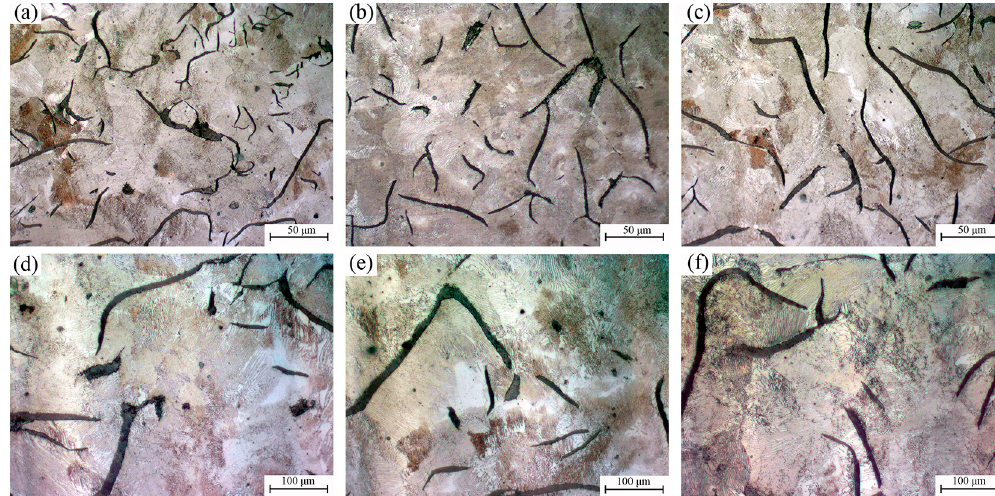
Figure 1. Optical images showing the matrix of samples inoculated by Zr ‐ FeSi ( a , d ), Sr ‐ FeSi ( b , e ), and SiC ( c , f ).